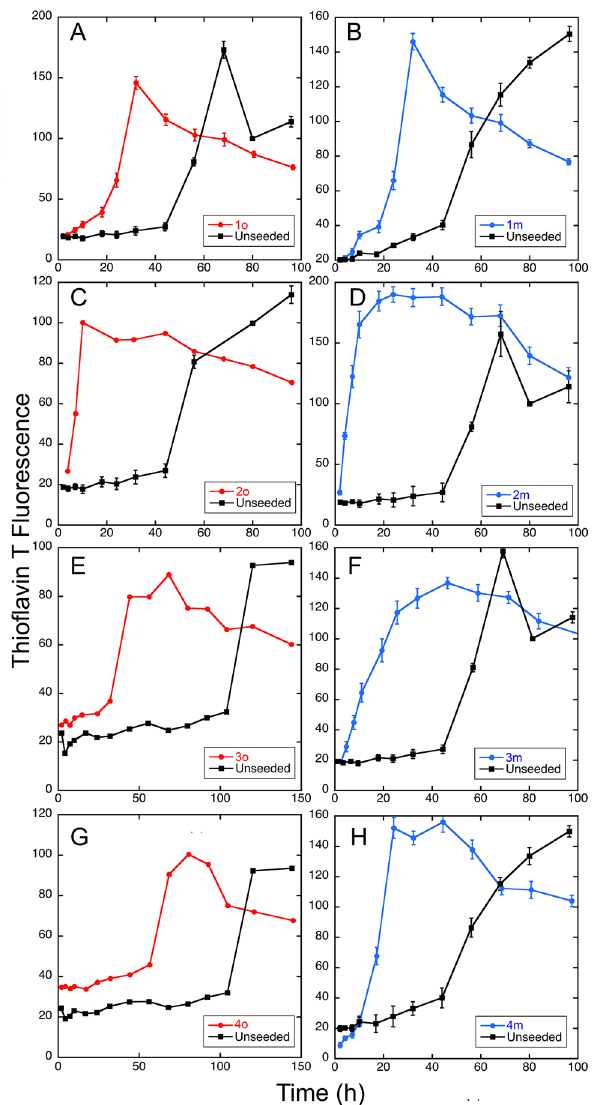
Figure 1. ThT Fluorescence demonstrates seeding by brain parenchyma (red) and meningeal (cerebrovascular, blue) isolates. ( A ) Seeding from Patient 1, brain parenchyma. ( B ) Seeding from Patient 1, meninges. ( C ) Seeding from Patient 2, brain parenchyma. ( D ) Seeding from Patient 2, meninges. ( E ) Seeding from Patient 3, brain parenchyma. ( F ) Seeding from Patient 3, meninges. ( G ) Seeding from Patient 4, brain parenchyma. ( H ) Seeding from Patient 4, meninges. In all cases, brain parenchyma refers to occipital lobe (“o”). Red circles = parenchyma seeding; blue circles = meninges (vascular) seeding; black squares = unseeded control performed at the same time as the seeding. Error bars are standard error of the mean of determinations from three samples, except for 1o and 4o, which were determinations from single